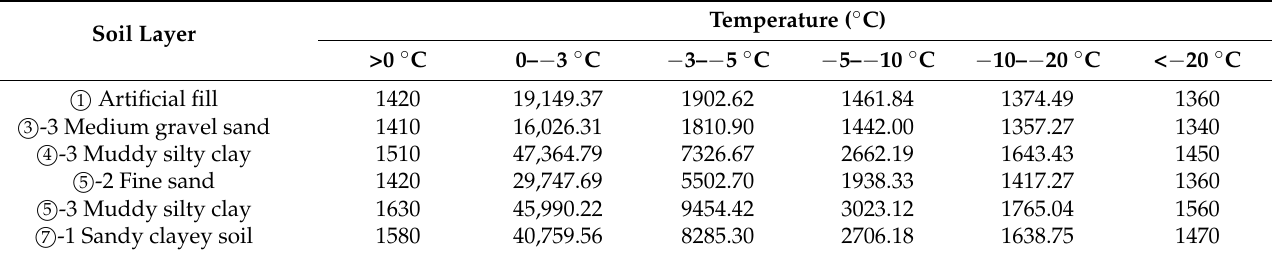
Table 4. Equivalent Specific Heat of soil layer (J/(kg · K)).